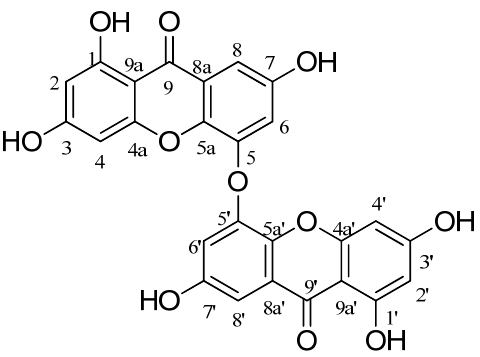
Figure 1. Chemical structure of compound 1 .